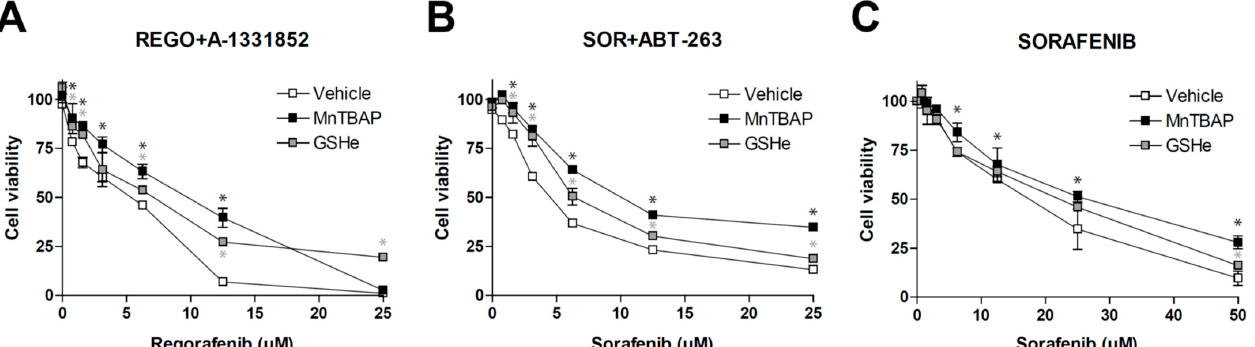
Figure 5. Antioxidants diminish the efficacy of sorafenib/regorafenib-based anti-cancer therapies. MTT assays in Hep3B cells were performed to evaluate potential cell death protection by SOD mimetic MnTBAP and GSHe, a cell permeable GSH supplier, in front of different experimental cancer therapies proposed for HCC treatment. ( A ) increasing doses of regorafenib in combination with the BCL-xL inhibitor A-1331852 (A, 0.1 µM). ( B ) increasing doses of sorafenib in combination with the BCL-2/BCL-xL inhibitor navitoclax (ABT-263) and ( C ) sorafenib alone ( n = 3). * p < 0.05 vs. control cells.